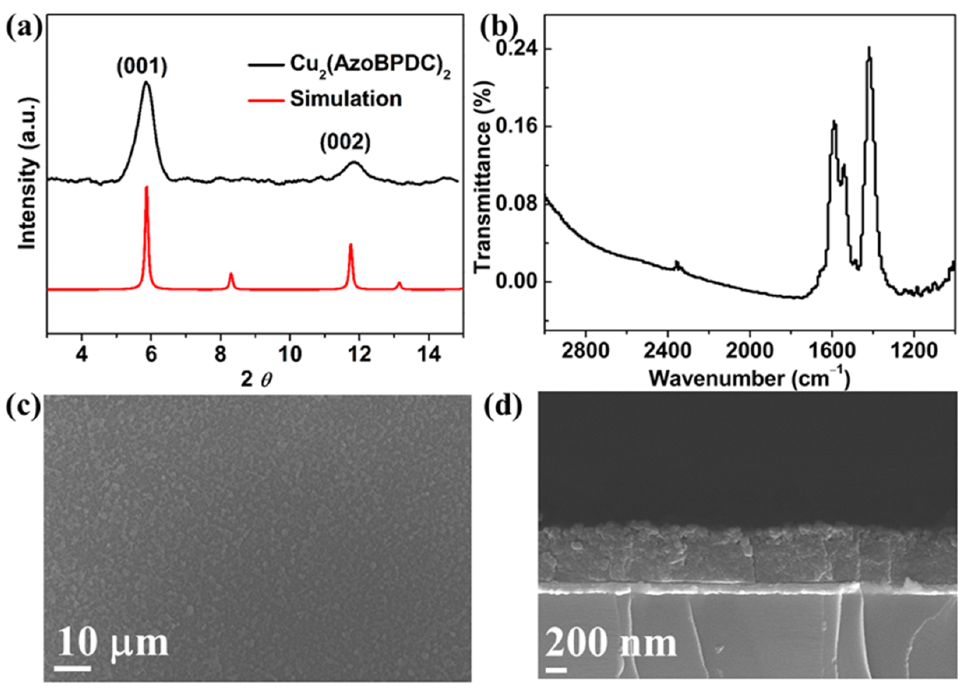
Figure 1. ( a ) XRD patterns of Cu 2 (AzoBPDC) 2 film; ( b ) IRRAS of Cu 2 (AzoBPDC) 2 film; SEM images of Cu 2 (AzoBPDC) 2 thin film ( c ) surface; ( d ) cross-section.